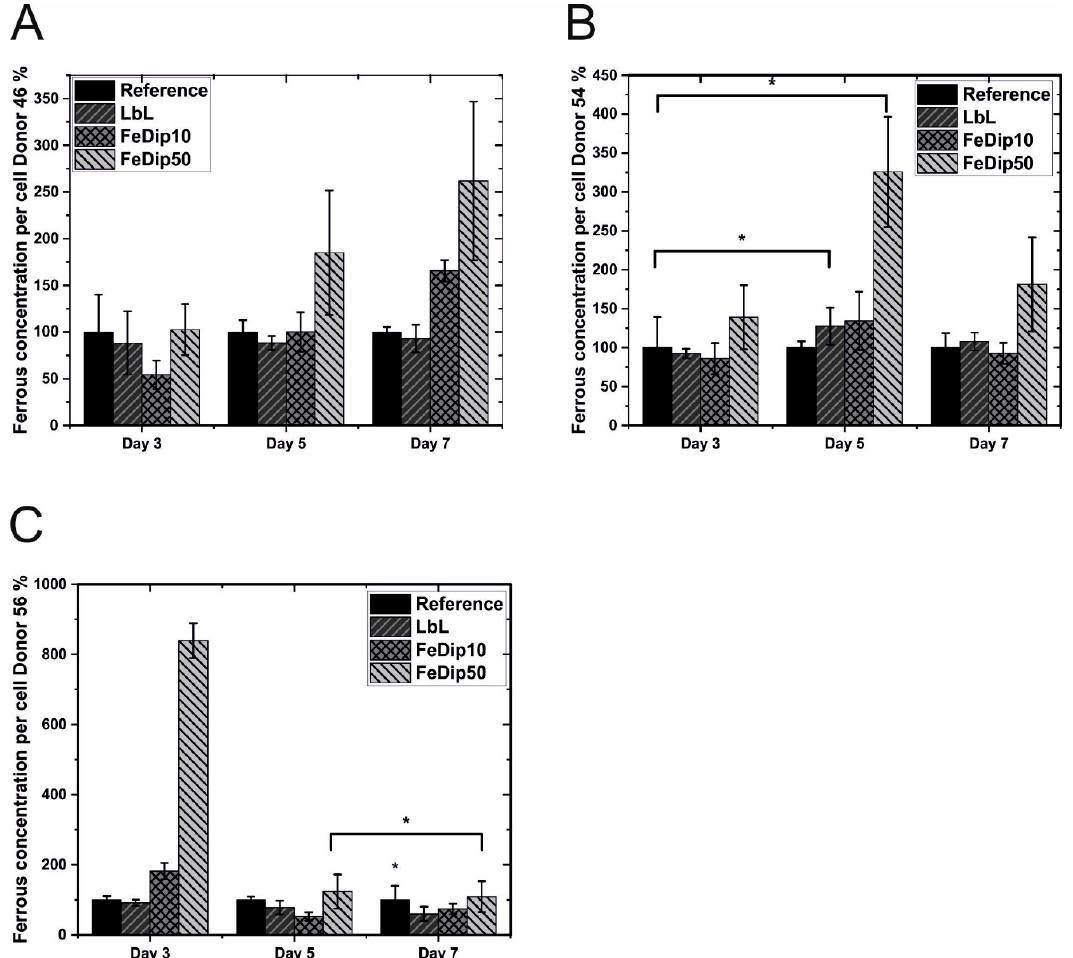
Figure 7. The bar diagrams represent the relative ferrous concentrations per cell for ( A ) donor 46, ( B ) donor 54, and ( C ) donor 56 grown on the indicated substrates. The values obtained for cells grown on TCPS substrates are set to 100% (the values for the references substrates also vary donor dependently. The absolute values for the reference substrates at day 3 are: donor 46 = 68.2 fMol/cell; donor 54 = 31 fMol/cell; donor 56 = 21.6 fMol/cell). All experiments were performed in triplicate. * p < 0.5 (analyzed by one-way ANOVA with Tukey test).